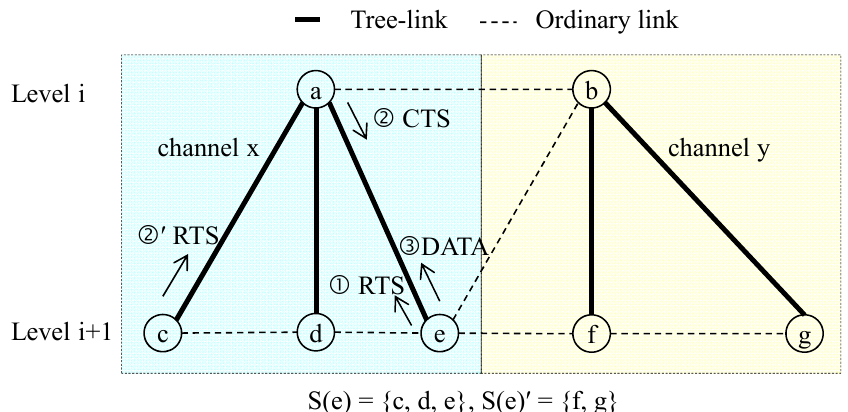
Figure 2. The use of multiple channels to reduce collision when using CSMA.